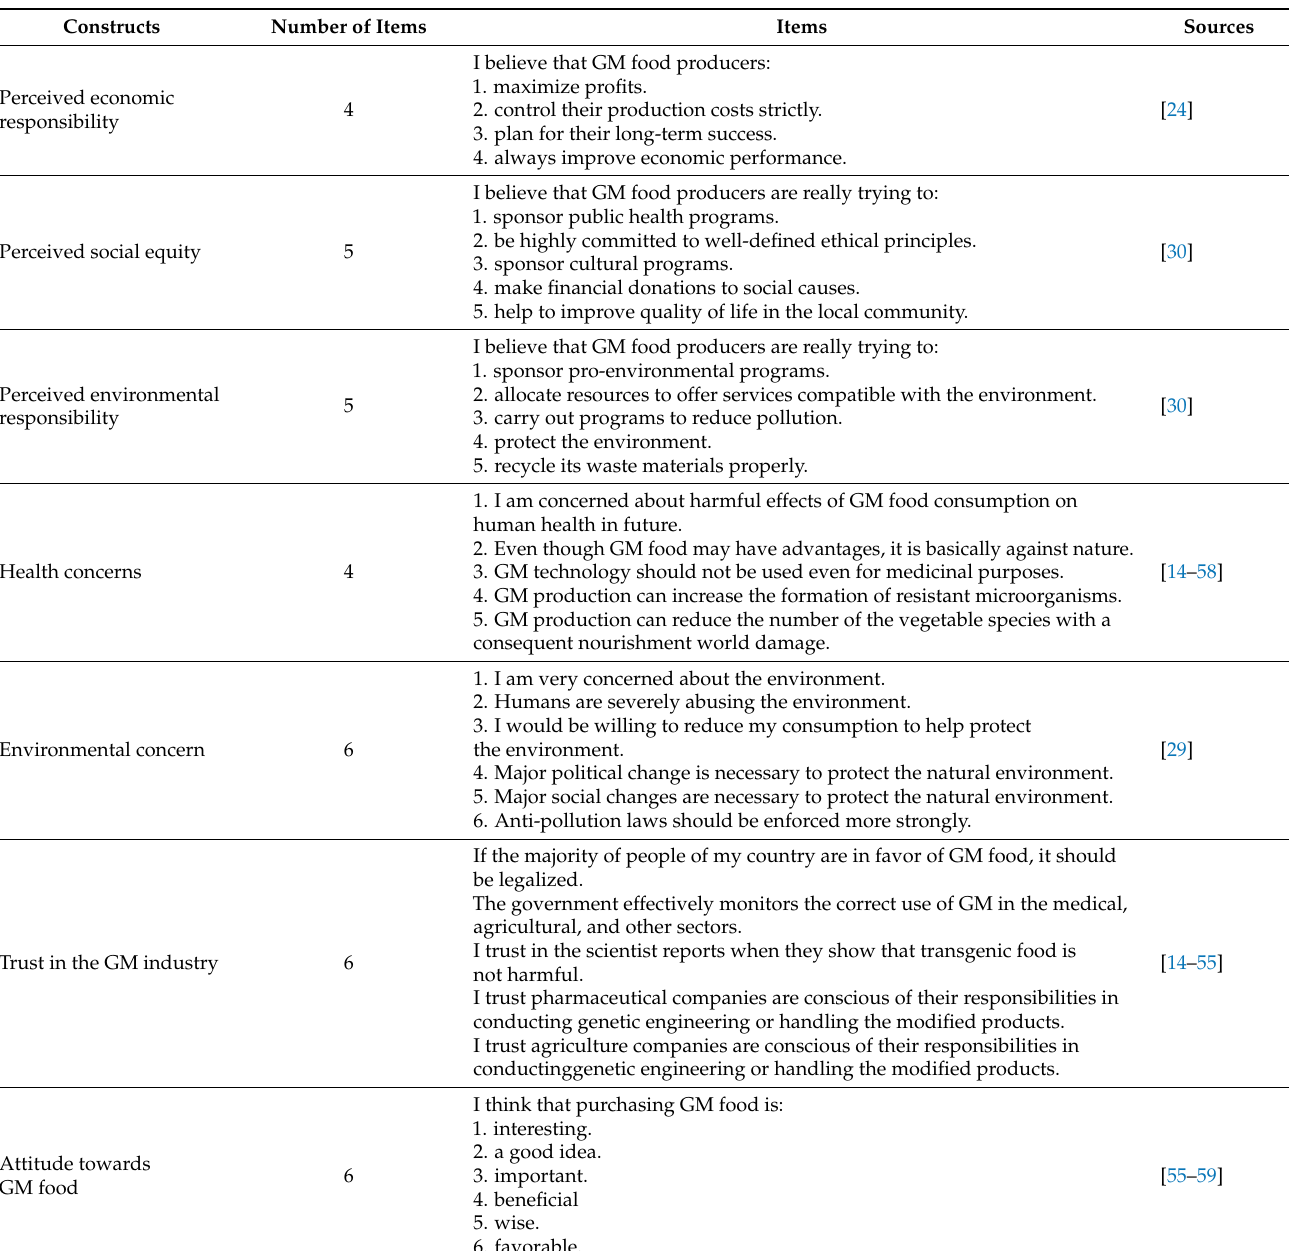
Table 1. Items used for measuring the